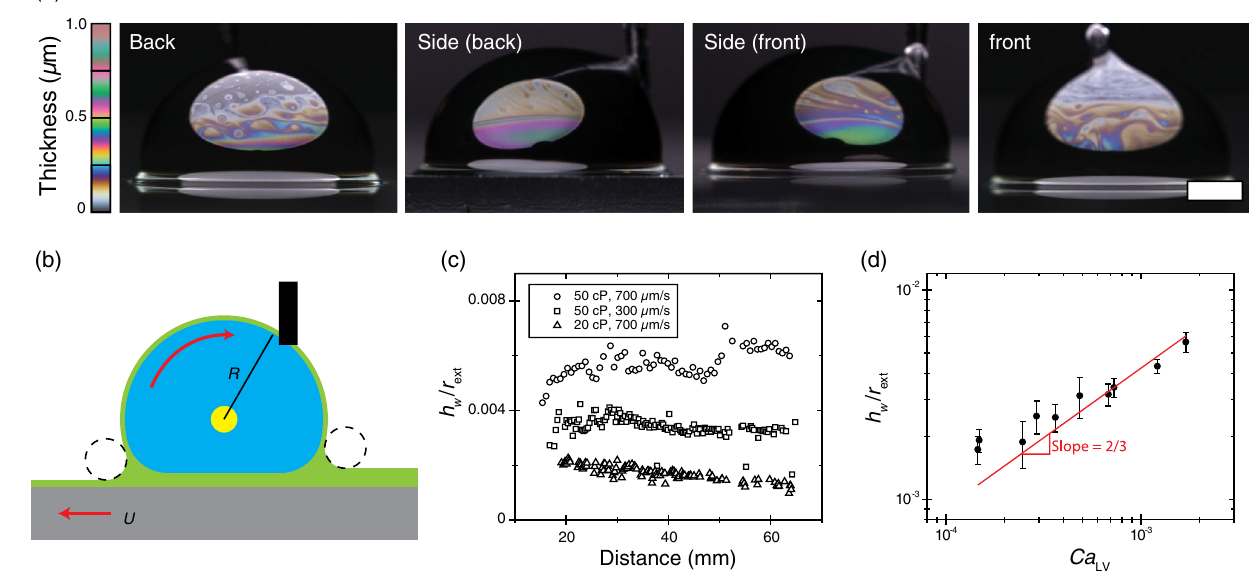
FIG. 5. (a) The wrapping layer imaged using color interferometry at different positions on the surface of a moving droplet. Note, the complex lubricant dynamics limit the extent to which LLD can be applied to h computationally and should be used only as a guide. V bar ¼ 1 mm. Note, the “ side (front) ” image is reflected to match the orientation of the other images. (b) Experimental schematic. The yellow dot indicates the position of the optical probe used to measure h number experiments. (d) Scaling of h